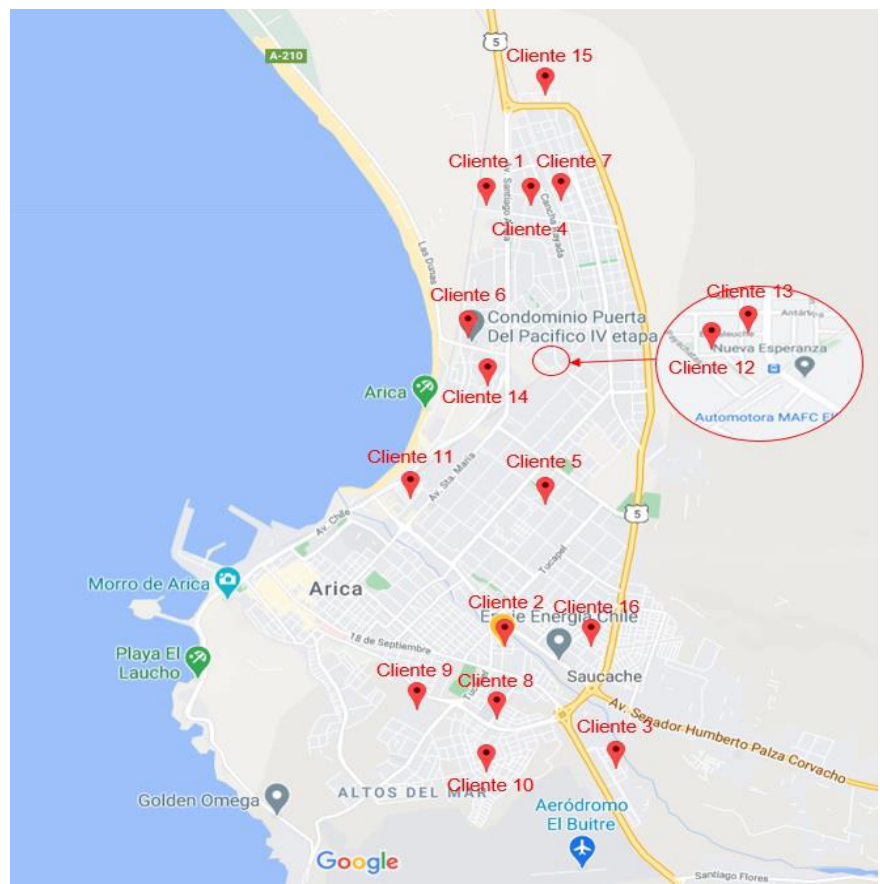
Figure 8. Satellite image of the terrestrial location of clients under study. Source: [46].